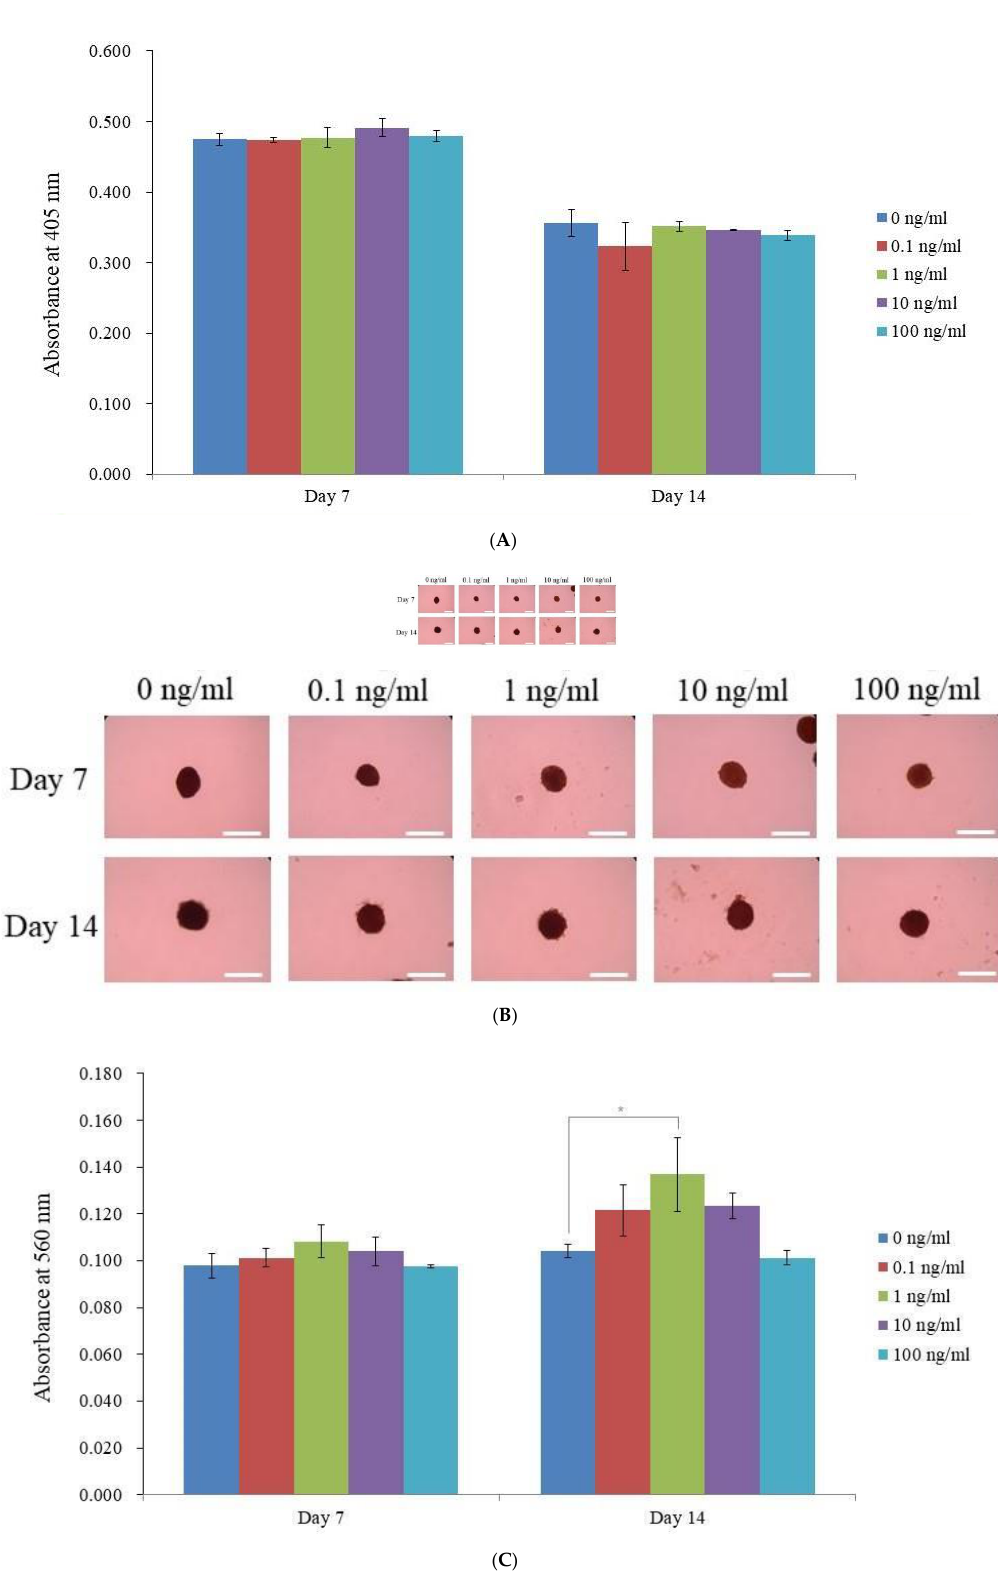
Figure 3. Analyzing the activity of alkaline phosphatase and Alizarin Red S staining. ( A ) Graphical results of alkaline phosphatase activity tests on days 7 and 14. ( B ) Results of Alizarin Red S staining on days 7 and 14. ( C ) Quantitative results and Alizarin Red S staining on days 7 and 14. * p < 0.05 vs. time-matched 0 ng/mL group on day 14.